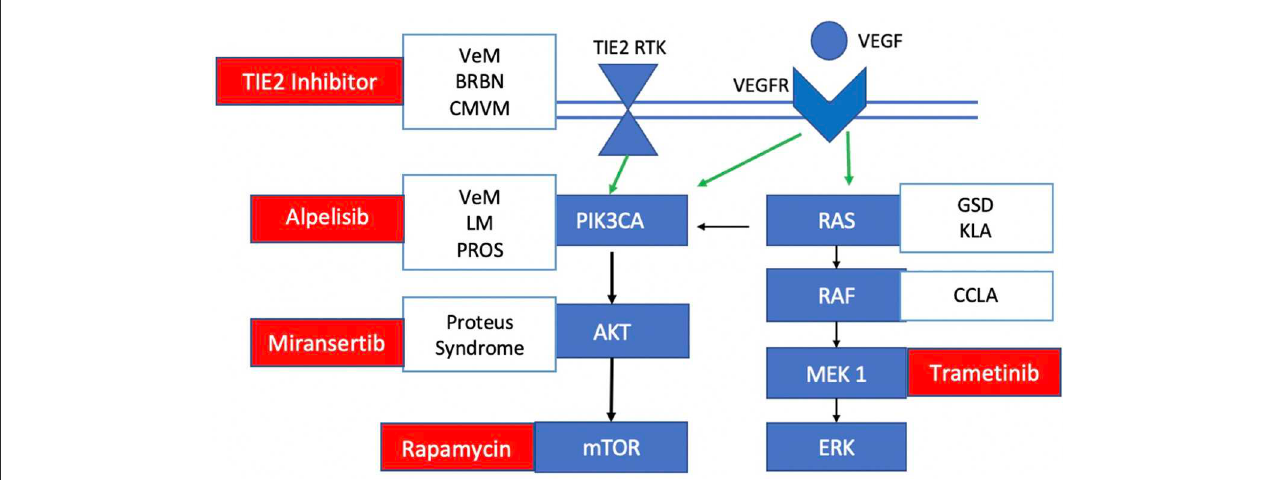
FIGURE2 Mutations and targeted therapies for slow-flow malformations. TIE2 RTK, TEK gene receptor tyrosine kinase; VEGF, vascular endothelial growth factor; VEGFR, vascular endothelial growth factor receptor. Somatic TIE2 mutations are observed in unifocal and multifocal venous malformations (VeMs), blue rubber bled nevus syndrome (BRBN) and cutaneomucosal venous malformations. Somatic PIK3CA mutations are seen in venous malformations, lymphatic malformations and PROS. Some central lymphatic anomalies such as Gorham Stout Disease (GSD) and kaposiform lymphangiomatosis (KLA) harbor RAS mutations while patients with central conducting lymphatic anomalies (CCLA) have ARAF mutations. Currently investigated targeted therapies for each component of the pathway in slow-flow malformations are shown in